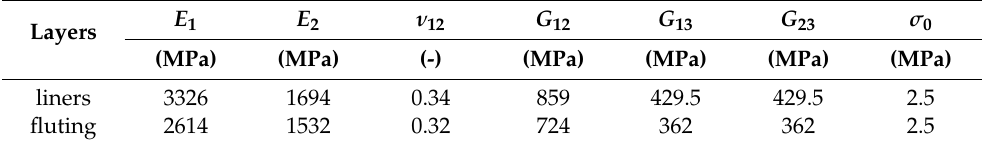
Table 1. Material properties of liners and fluting of intact corrugated cardboard.